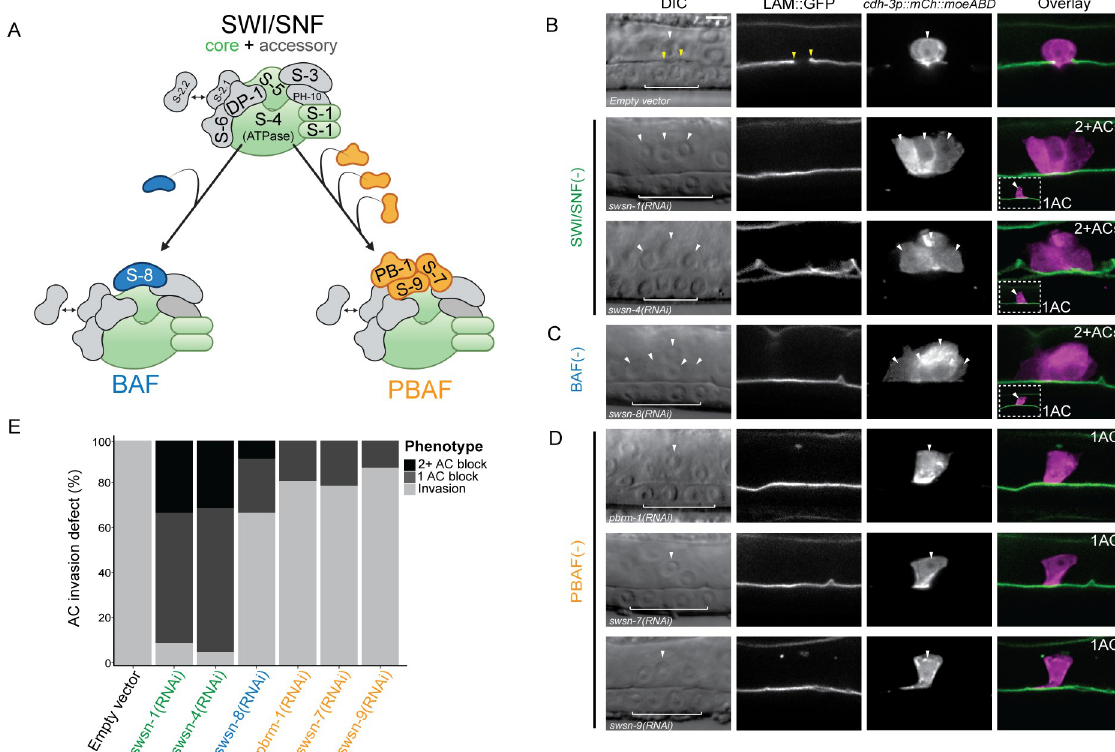
Fig 2. Enhanced RNAi targeting SWI/SNF core, BAF, and PBAF subunits results in penetrant invasion defects. (A) Schematic depicting the C . elegans SWI/SNF common factors (core and accessory subunits, top), along with BAF (left, blue), and PBAF (right, orange) assemblies. (B-D) DIC (left), corresponding fluorescence images (middle), and fluorescence overlay (right) representing loss of AC (magenta, cdh-3p :: mCherry :: moeABD ) invasion through the BM (green, laminin :: GFP ) following RNAi depletion of SWI/SNF core ( swsn-1 and swsn-4 ) (B) , BAF ( swsn-8 ) (C) , and PBAF ( pbrm-1 , swsn-7 , and swsn-9 ) (D) subunits. White arrowheads indicate ACs, yellow arrowheads indicate boundaries of breach in the BM, and white brackets indicate 1˚ VPCs. In cases where multiple cells expressed the AC reporter (2+ACs) in the same animal following RNAi treatment, each cell expressing the AC reporter is indicated with a white arrowhead. In cases where multiple cells expressed the AC reporter (2+ACs), a representative image from the same treatment of a single AC that fails to breach the BM is displayed as an inset (white dashed box, bottom left). Scale bar, 5 μ m. (E) Stacked bar chart showing the penetrance of AC invasion defects following treatment with SWI/SNF RNAi depletion, binned by AC phenotype (n � 50 animals examined for each